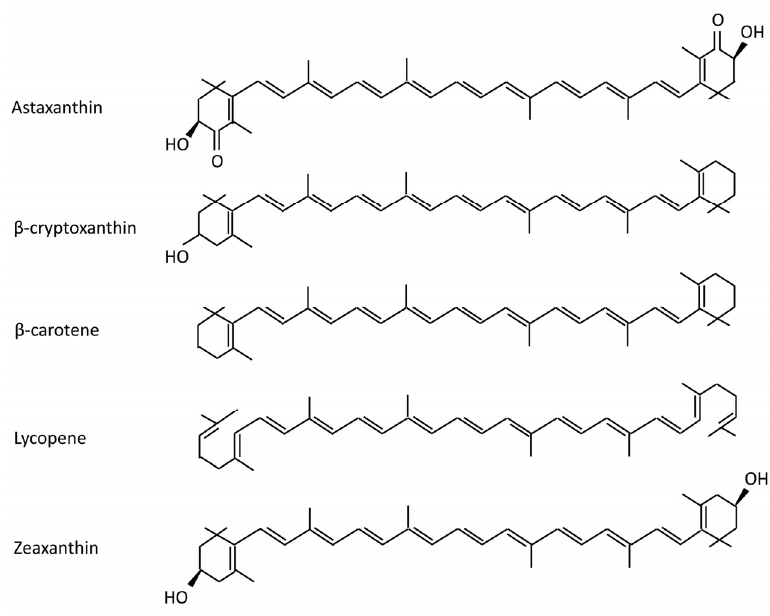
Figure 1. Chemical structures of selected carotenoids.